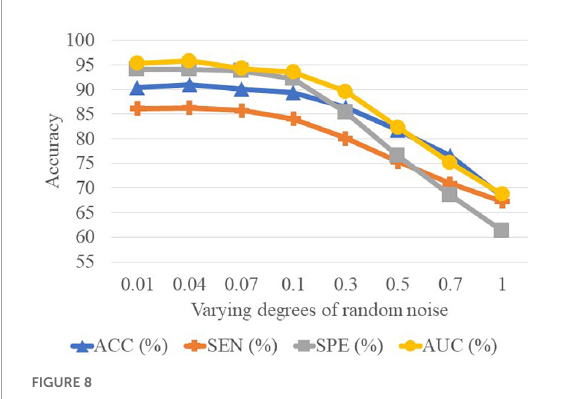
TABLE 6 Classification result of three data sets on MBNF method.